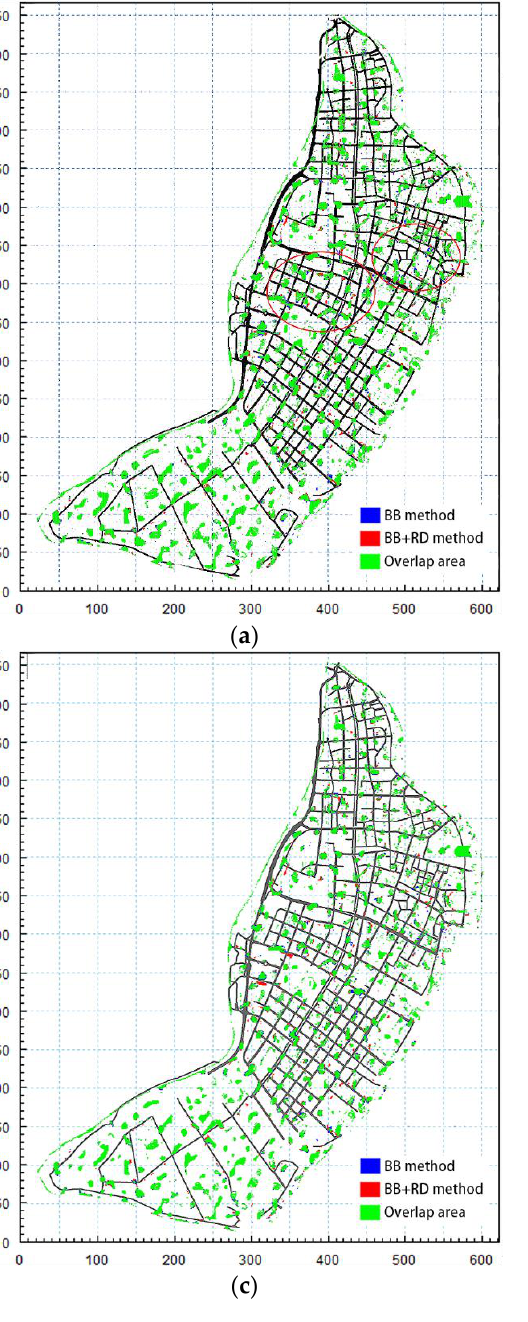
Figure 11. Contrast results for inundation areas when using BB, RD, and BB + RD methods: ( a ) cases C1 and C8; ( b ) cases C1 and C7; ( c ) cases C2 and C10; ( d ) cases C2 and C9.